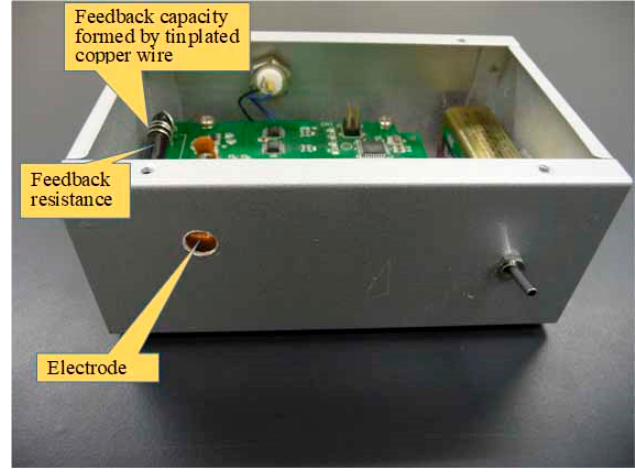
Figure 5. Photograph of the sensor for the current electrostatically induced by walking motion.